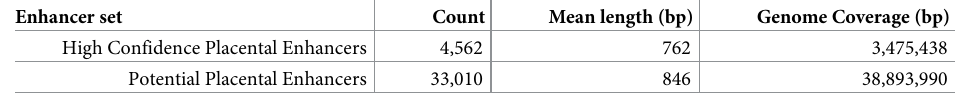
Table 1. Statistical summary of genome-wide placental enhancer